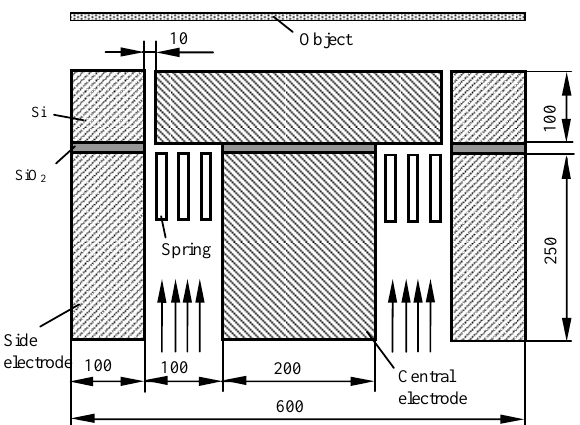
Fig. 4. Original design of the pneumatic actuator.